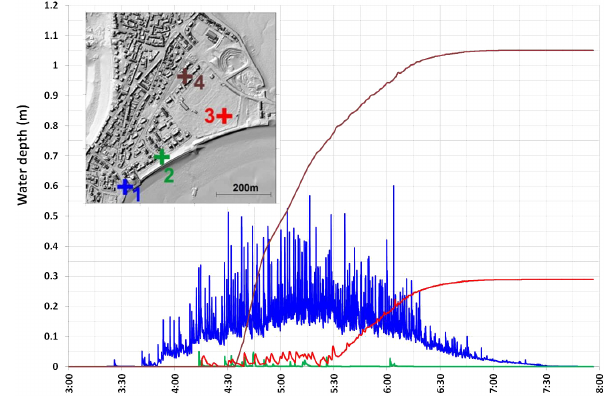
Figure 8. Evolution of the water depth on four numerical gauges during the SURF-WB simulation on the